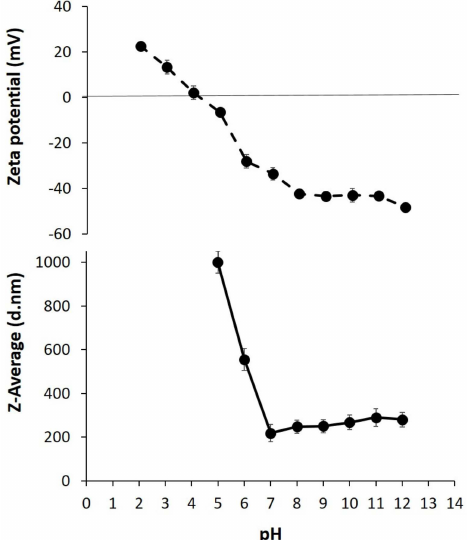
Figure 1. Zeta potential ( upper panel ) and Z-average size ( lower panel ) measurements of Nigella sativa defatted seed cake ( Ns DSC)-derived protein concentrate (PC) performed at di ff erent pH values. PC sample contained 1.0 mg protein dissolved in 1.0 mL of distilled water at pH 12. All the results were reported as mean ± standard deviation. Further experimental details are given in the